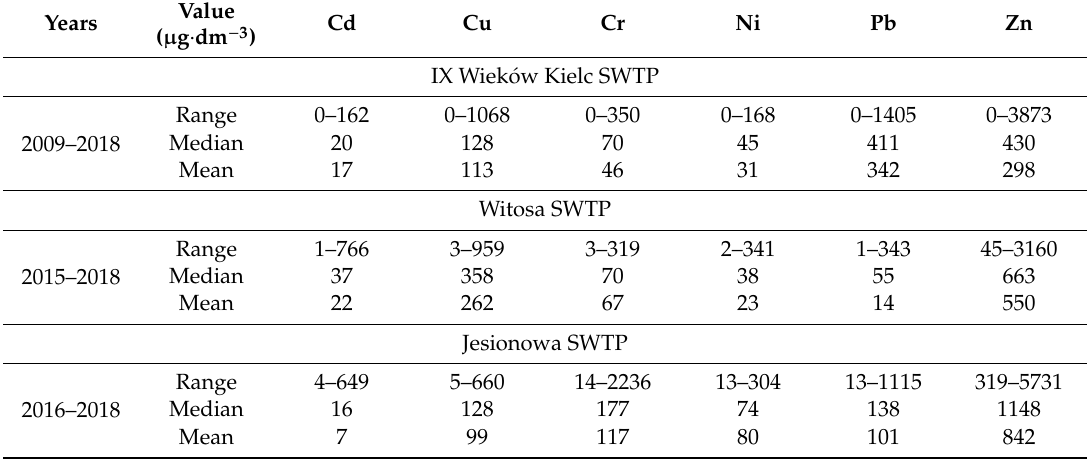
Table 2. Summary statistics describing heavy metals concentrations in the analysed